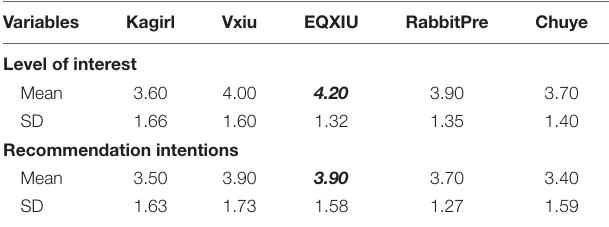
TABLE 2 | Innovation platforms, level of interest, and recommendation intentions.